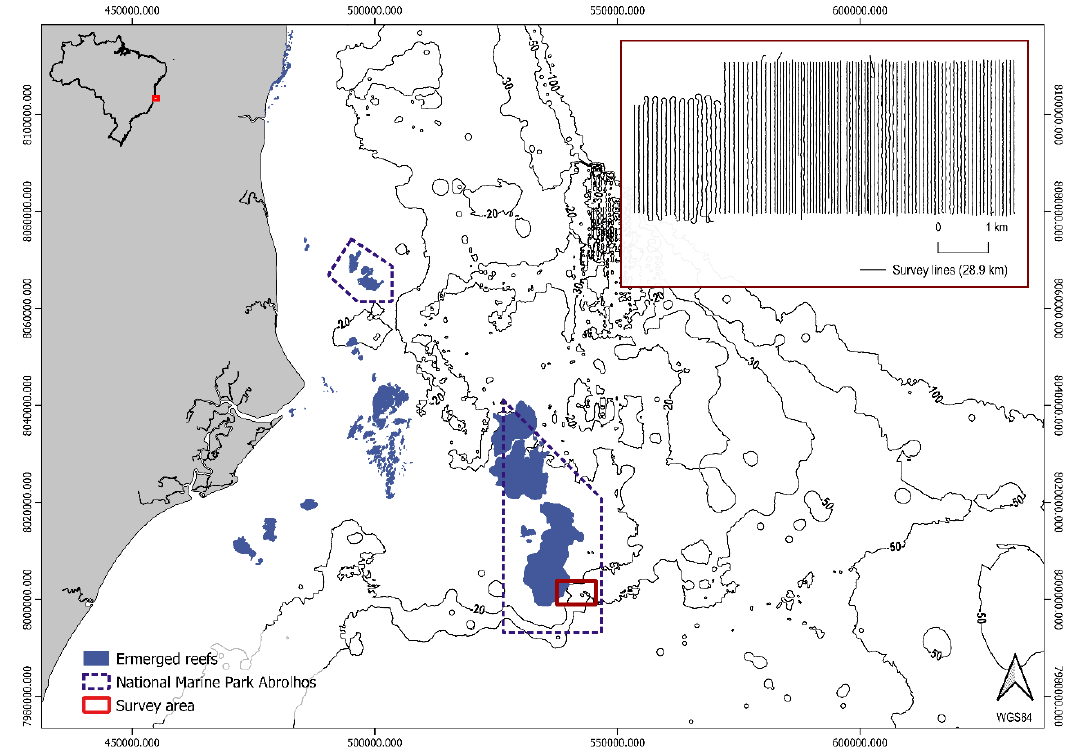
Figure 1. Survey area location, along the eastern Brazilian coast. The detailed frame in the top right corner shows the survey plan (28.9 km of acquisition tracklines).